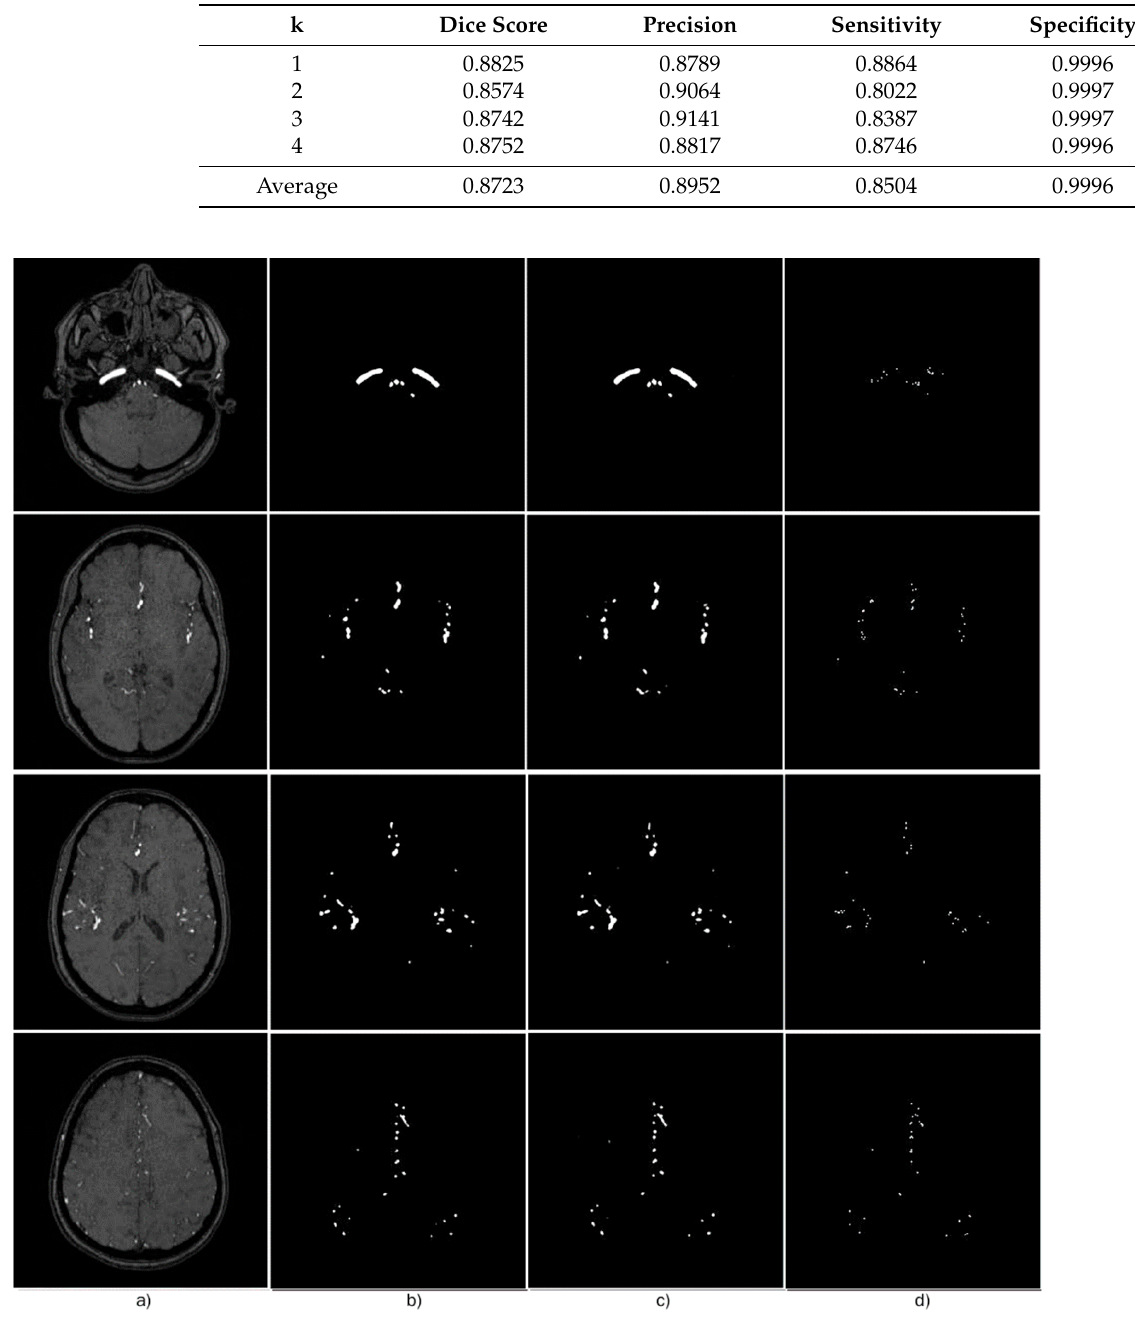
Figure 6. Example of vessel segmentation performed to MRA images. ( a ) MRA slices, ( b ) Segmen- tation target, ( c ) Prediction from the proposed model, and ( d ) Segmentation error (the difference between segmentation target and prediction).